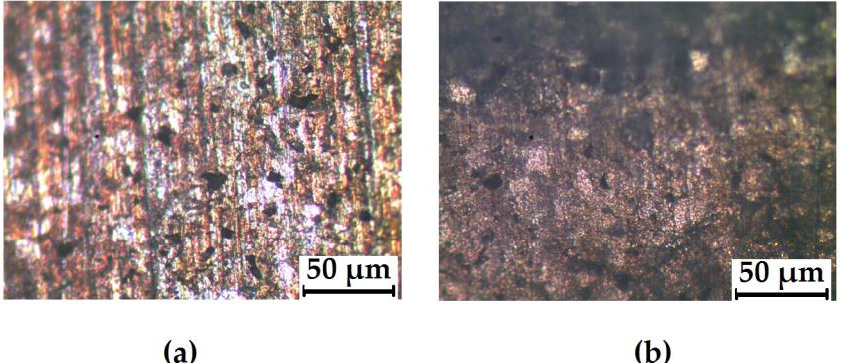
Figure 4. Anodic polarization curve of zinc. 1 — non-modified zinc, 2 — zinc modified with a VS solution, 3 — zinc modified with a solution of a (VS + AS) mixture, 4 — zinc modified with a solution of a (VS + BTA) mixture. Table 3. The effect of zinc surface modification on the value of pitting potential.